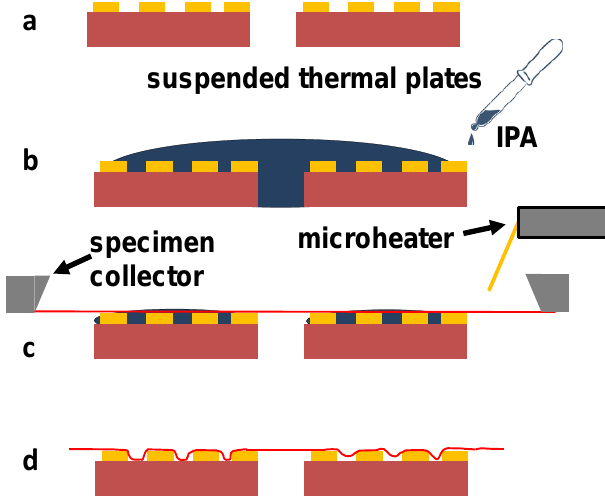
Figure 9. Schematic diagrams representing nanofiber placement onto a platinum resistance thermometer plates. ( a ) suspended plates, ( b ) a small drop of isopropanol (IPA) is placed on the platforms ( c ) after the IPA evaporates, the microheater cuts the fibers, ( d ) The evaporating IPA pulls the fiber into contact with the plate.